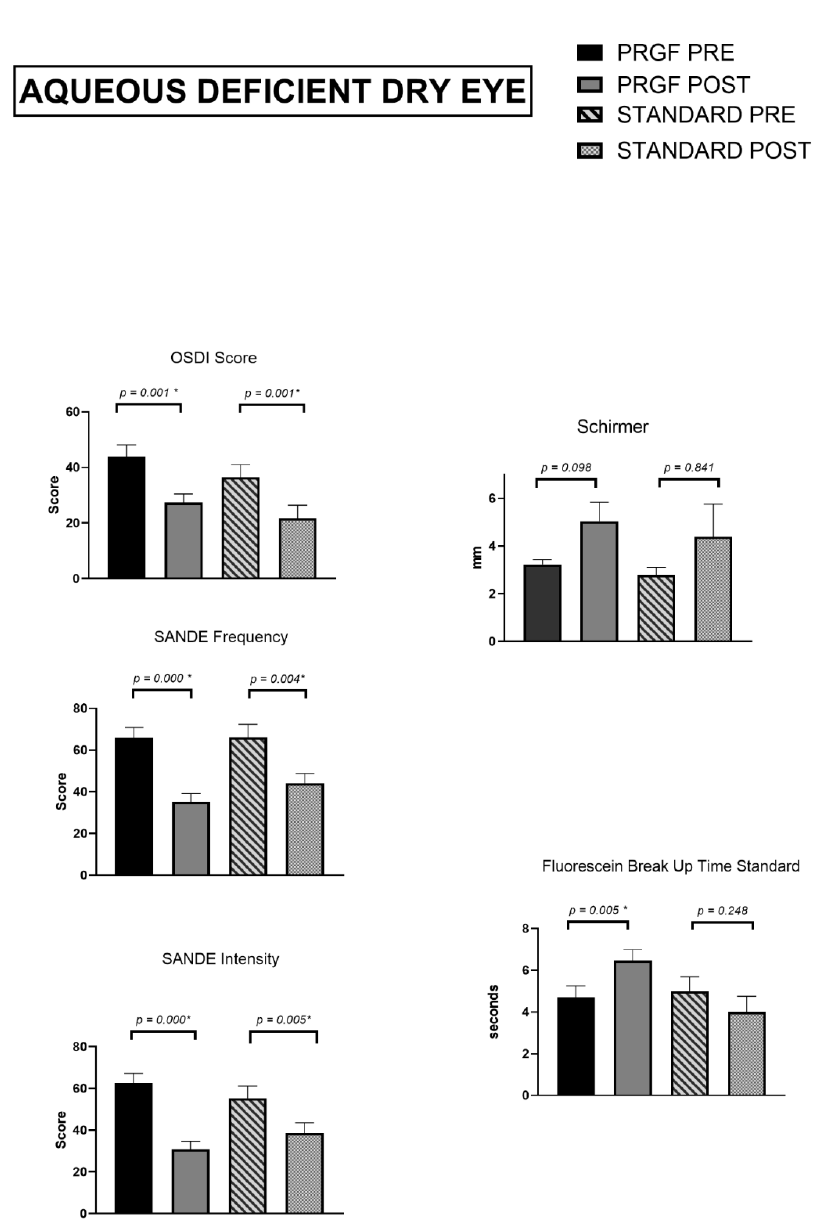
Figure 5. Tear film and psychometric questionnaires for Aqueous Deficient Dry Eye. Asterisks (*) in the graphs indicate statistical differences between groups (p<0.05).